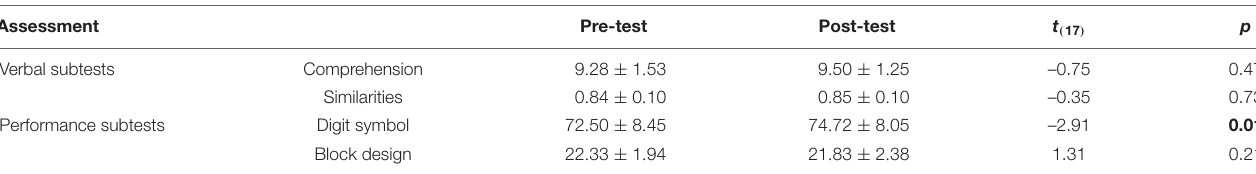
TABLE 1 | Scores in pre- and post-tests in pilot study ( M ± SD